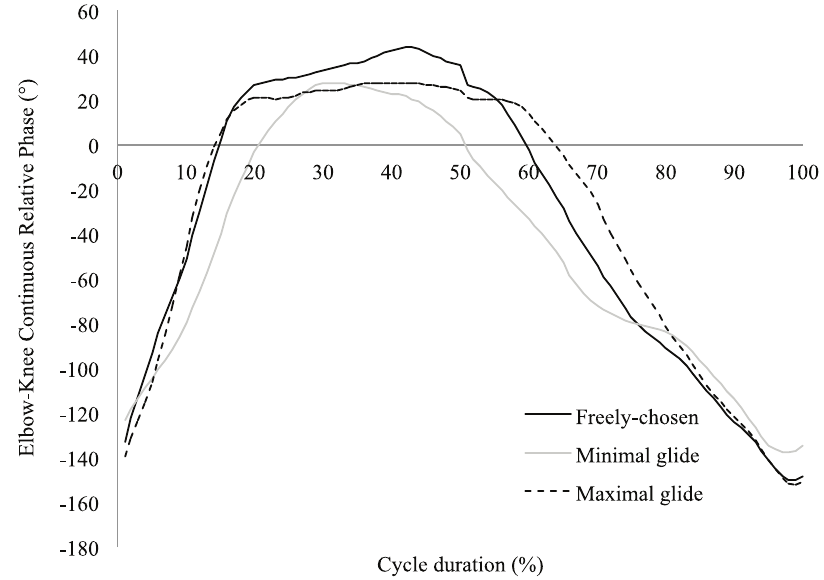
Figure 1. Elbows-knees continuous relative phase (mean of six cycles from all participants) for the three coordination conditions. One stroke cycle corresponded to the period from one maximal knee flexion (0%) to the next maximal knee flexion (100%).